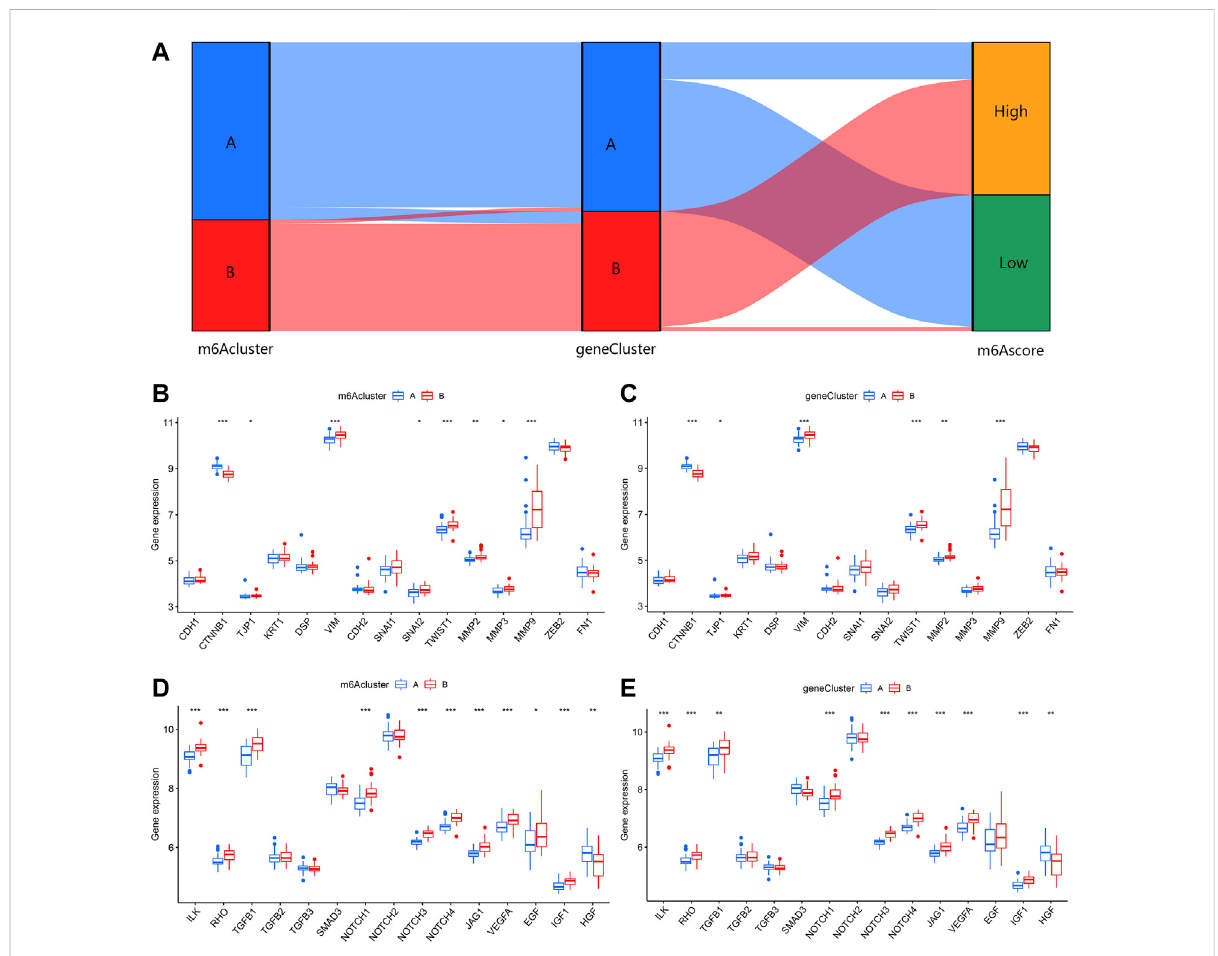
FIGURE 9 Effect of m6A patterns on differentiation of IPF. (A) Sankey diagram revealing relevance between m6A patterns, m6A gene patterns, and m6A scores. (B) DifferentexpressionlevelofepithelialmarkersandmesenchymalmarkersbetweenclusterAandclusterB. (C) Differentexpressionlevelof epithelialmarkersandmesenchymalmarkersbetweengeneclusterAandgeneclusterB. (D) Differentexpressionlevelofregulatoryfactorsof fi brosis between clusterA and clusterB. (E) Different expression level of regulatory factors of fi brosis between gene clusterA and gene clusterB. * p < 0.05, ** p < 0.01, and *** p < 0.001.